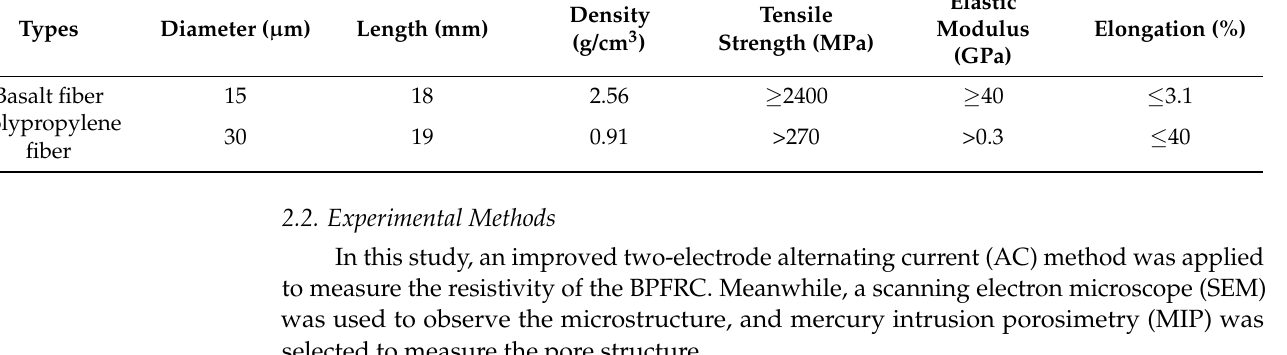
Table 3. Physical properties of basalt fiber and polypropylene fiber.